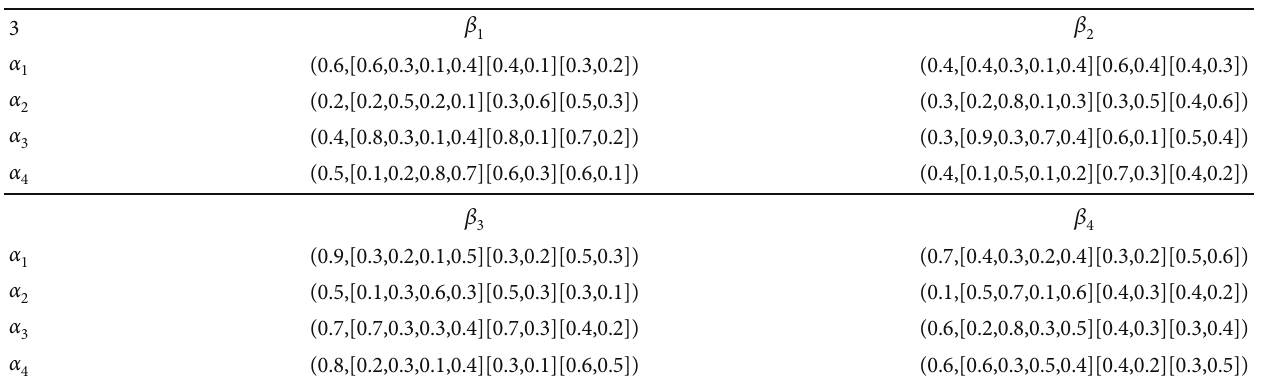
Table 3: Decision matrix of expert -3 (H 3